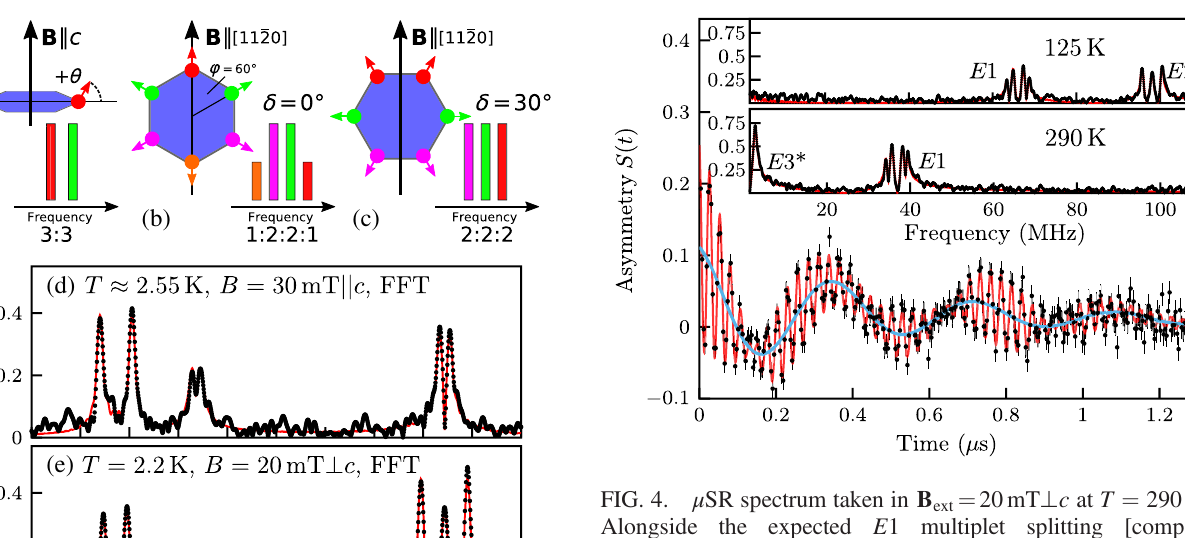
FIG. 4. μ SR spectrum taken in B Alongside the expected E 1 multiplet splitting [compare Fig. 3(e)], there is an additional component termed E 3 (cid:3) that precesses at the (much lower) Larmor frequency of the applied field (blue line), indicating that some muons do not experience any internal field. Insets: FT at T ¼ 125 K (top) and T ¼ 290 K (bottom). The E 3 (cid:3) line corresponding to precession in B absent at lower FIG. 3. (a) – (c) Schematic illustration of how an external j for stopping sites magnetic field breaks the degeneracy of j B int with the same magnitude but different directions of B . Only int those sites shown in the same color share the same magnitude of þ B j , resulting in a multiplet splitting and the vector sum j B int ext jj c causes a doublet, B ⊥ c amplitude ratio as depicted: (a) B ext ext causes (b) a quadruplet ( δ ¼ 0 ) and (c) a triplet ( δ ¼ (cid:4) 30 °); (d) FT of μ SR spectra in B ¼ 30 mT jj c at T ¼ 2 . 55 K and (e) FT of μ SR spectra in B ¼ 20 mT jj½ 1120 (cid:2) ⊥ c at T ¼ 2 . 2 K.